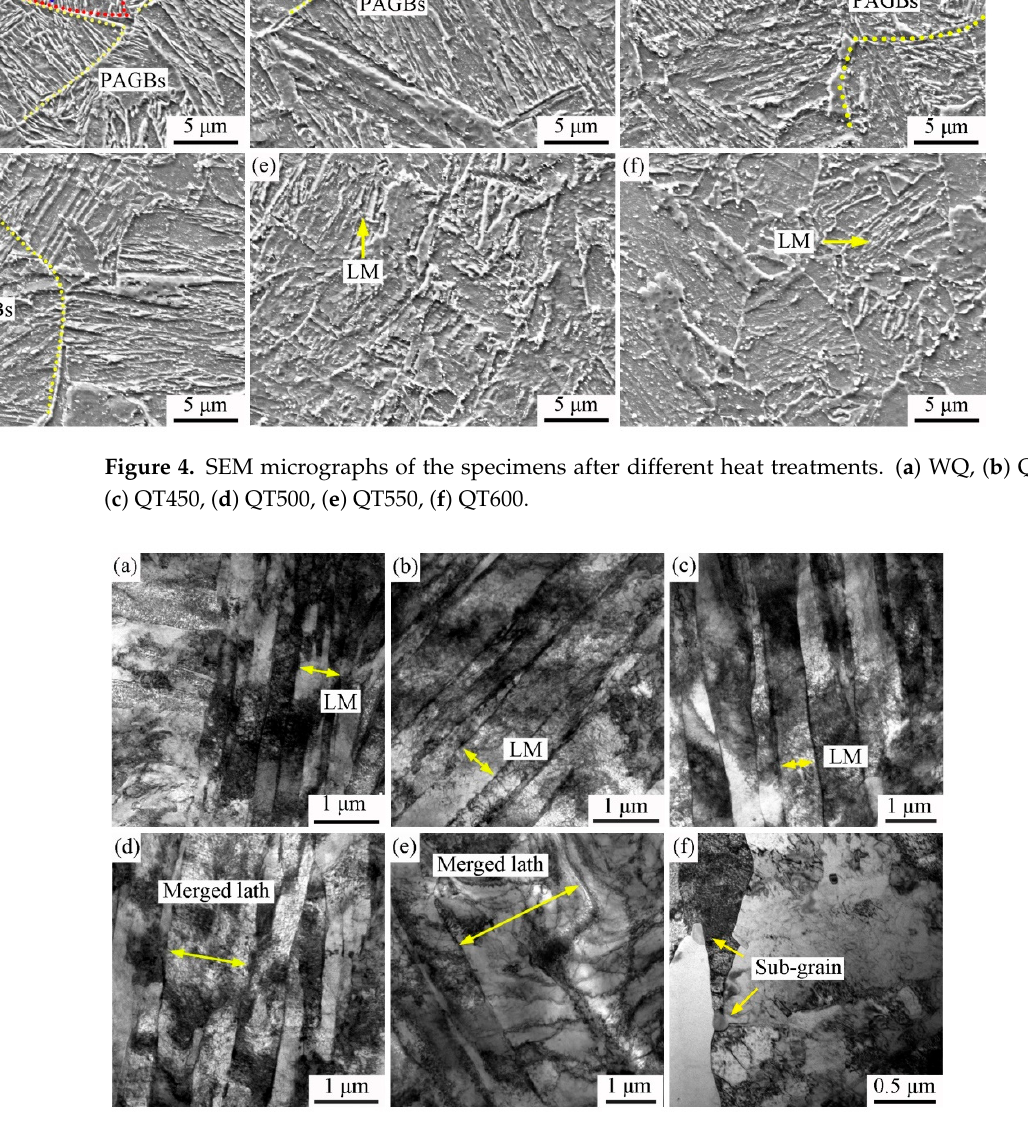
Figure 4. SEM micrographs of the specimens after different heat treatments. ( a ) WQ, ( b ) QT400, ( c ) QT450, ( d ) QT500, ( e ) QT550, ( f ) QT600.